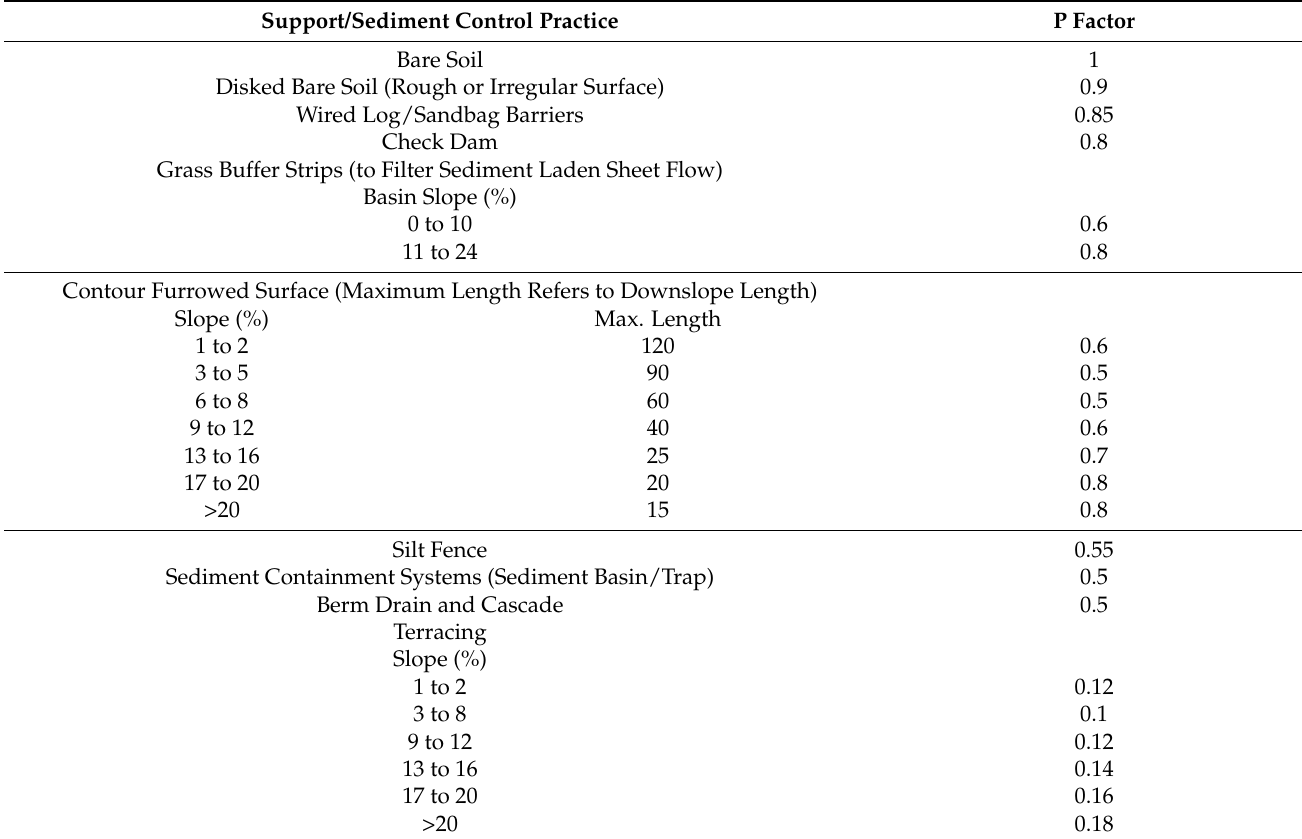
Table 5. Conservation practice, P factor, for BMPs at construction/developing sites 1 [11,12,27–29]. Support/Sediment Control Practice P Factor Bare Soil Disked Bare Soil (Rough or Irregular Surface)